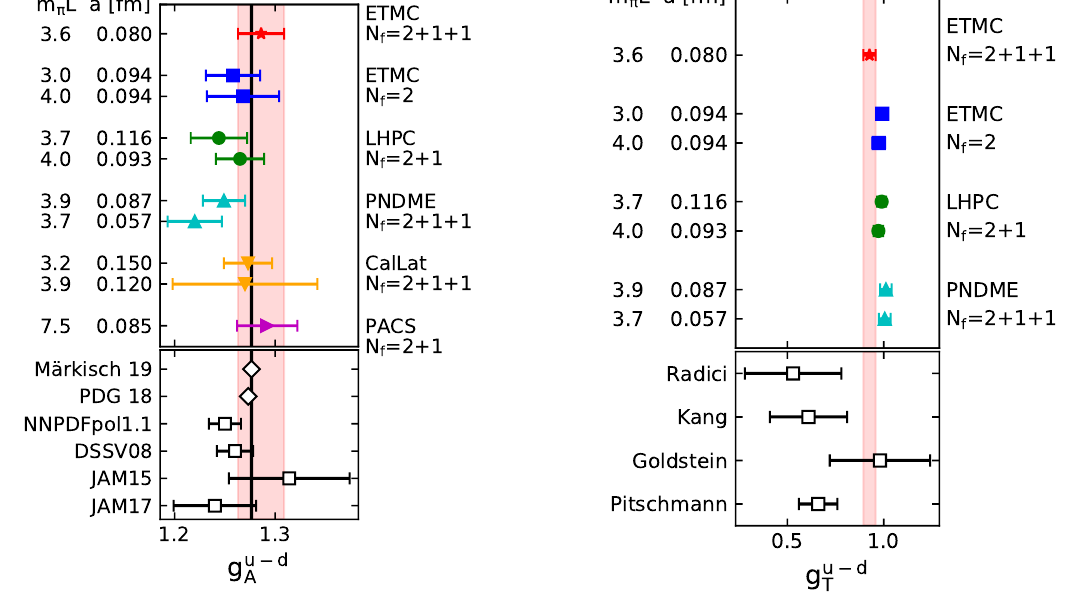
Figure 7: A comparison of recent lattice QCD and phenomenological results on g u − d (left) and g u − d (right). The error band is the one associate with the analysis of the T twisted mass ensemble cB211.072.64. Open symbols are from phenomenological analysis of experimental